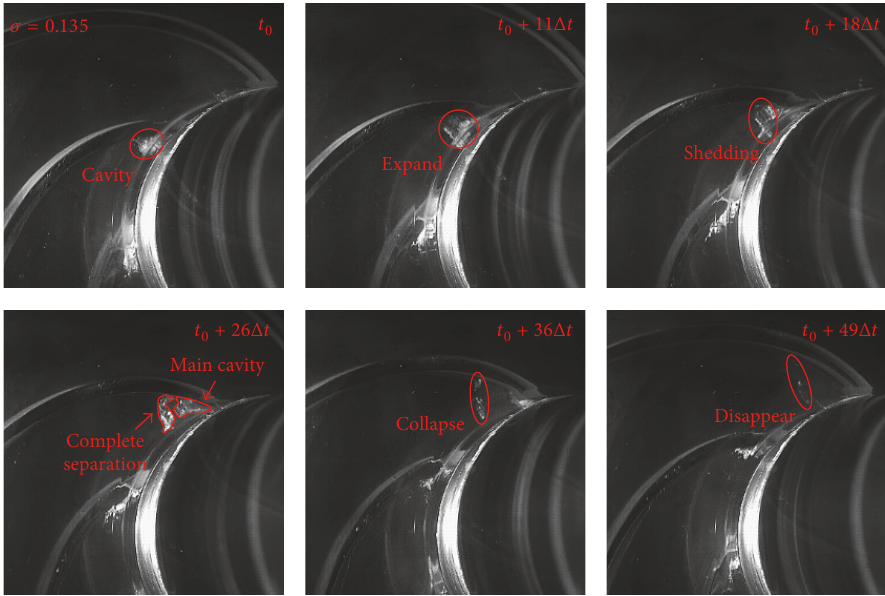
Figure 13: Cavitation developing process at cavitation number 𝜎 = 0.135